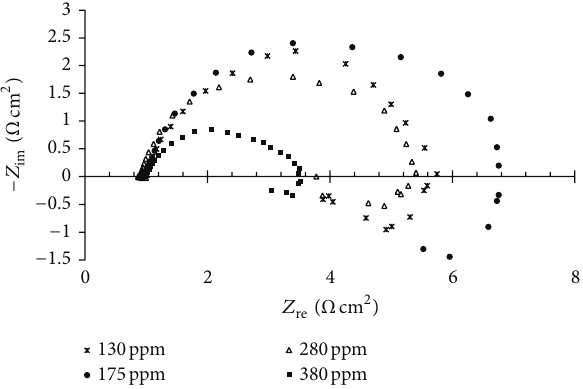
Figure 1: The electrorecovery cell with T-shape electrodes under load.